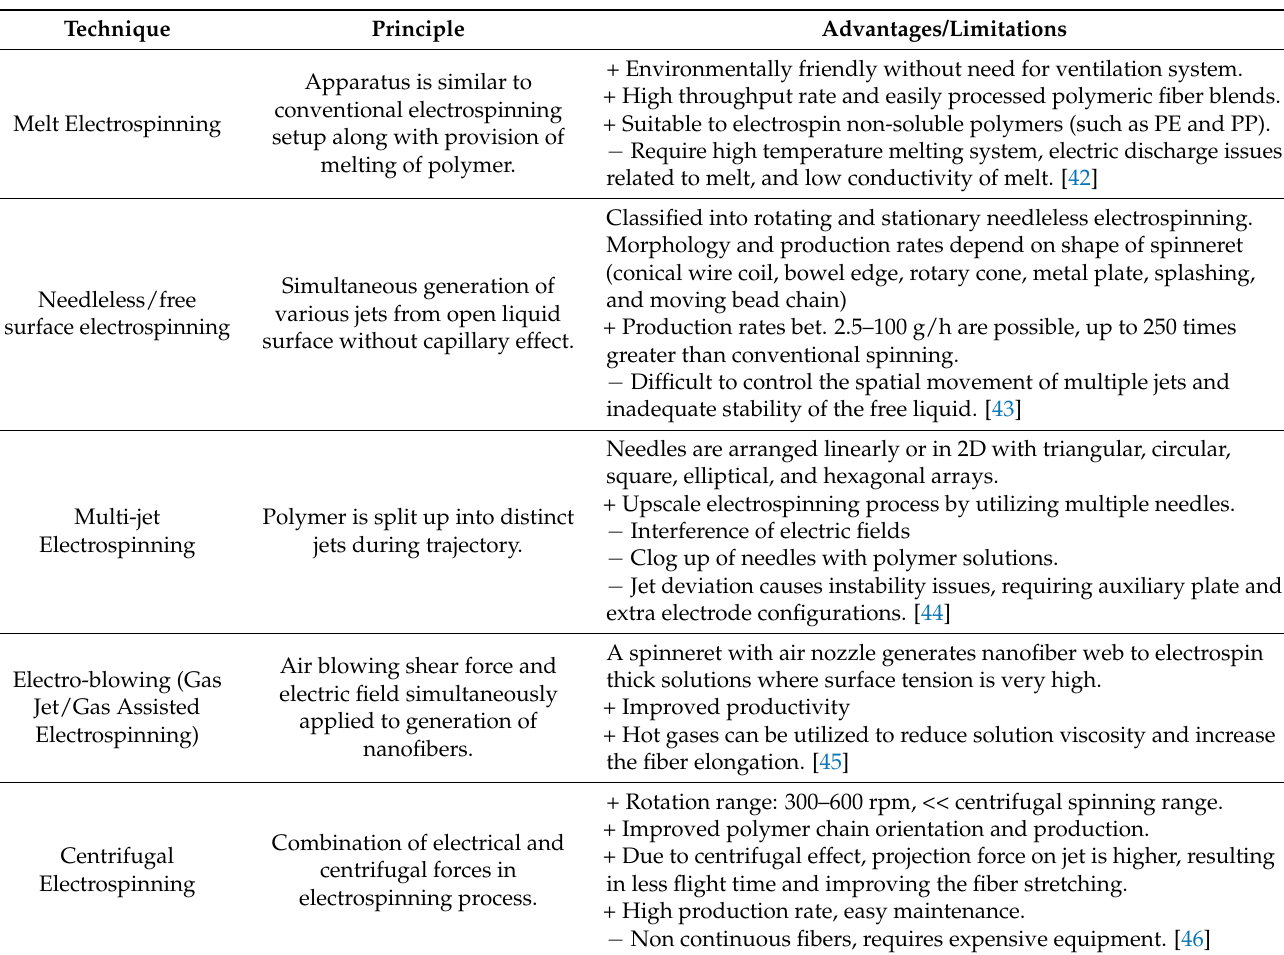
Table 2. Polymer nanofibers electrospinning